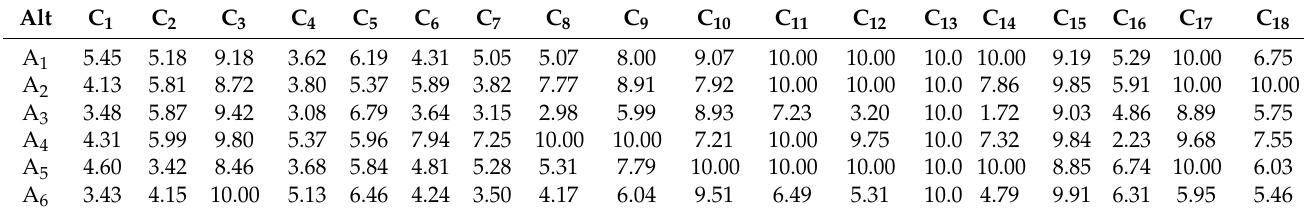
Table 3. Decision